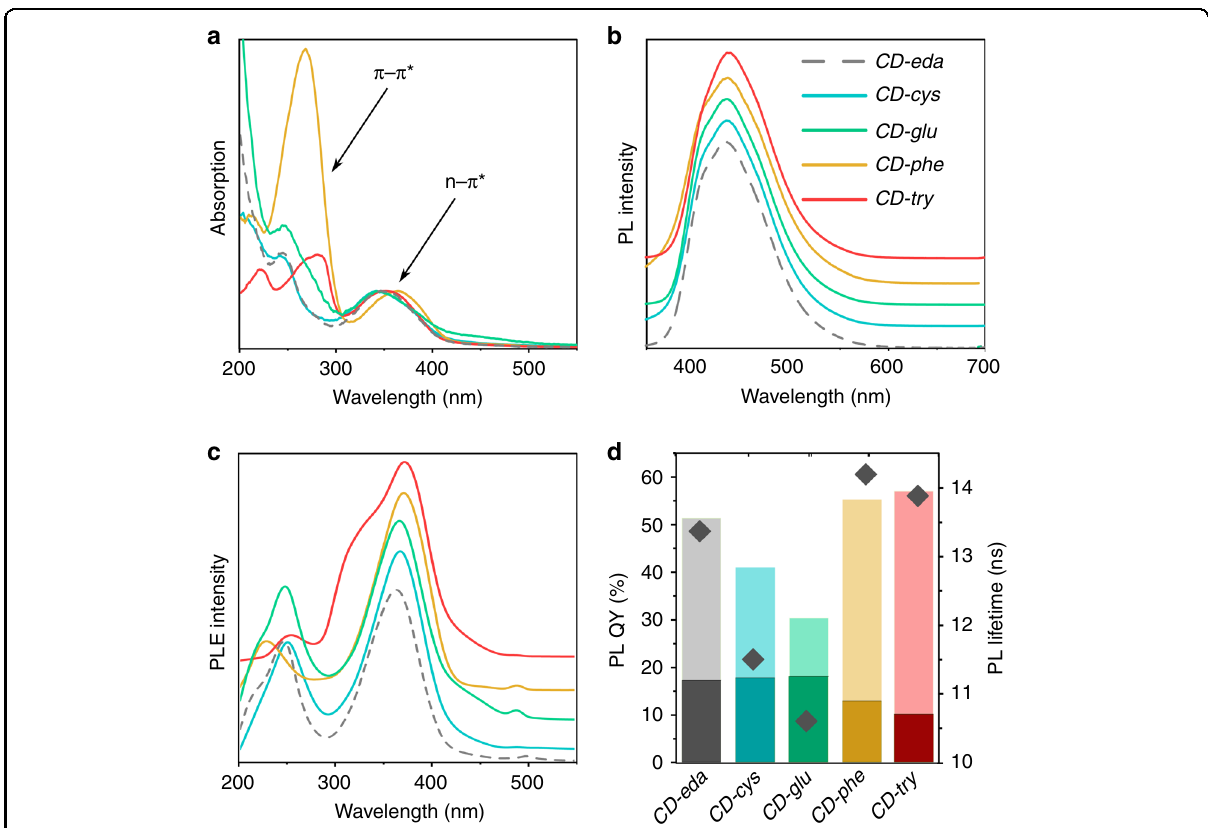
Fig. 4 Optical properties of fi ve CD samples. CD-eda (gray), CD-cys (cyan), CD-glu (green), CD-phe (orange), and CD-try (red). a Absorption spectra; b normalized PL spectra arbitrarily offset for clarity of presentation; the excitation wavelength was 350 nm; c normalized PLE spectra arbitrarily offset for clarity of presentation and monitored at 490 nm; d PLQYs (bars) of as-prepared (light color) and UV-exposed (dark color; see text) CDs, together with their average PL lifetimes (diamond symbols) in water. CDs were exposed to UV ( λ = 366 nm) irradiation for 420